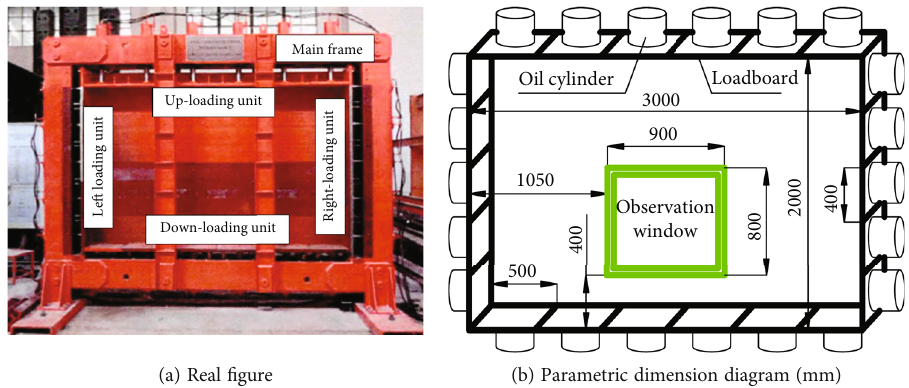
Figure 5: Picture of the testing device for similar